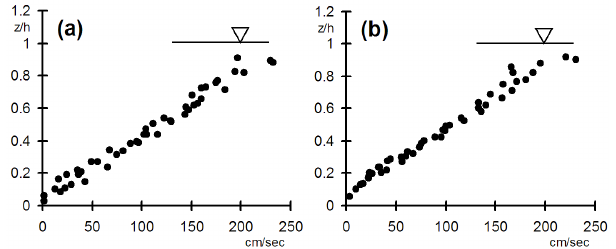
Fig. 7. Velocity profiles for experiments with channel slopes of (a) 13 ◦ and (b) 17 ◦ , with 2.9-mm sediment and a 2ls − 1 water sup- ply.